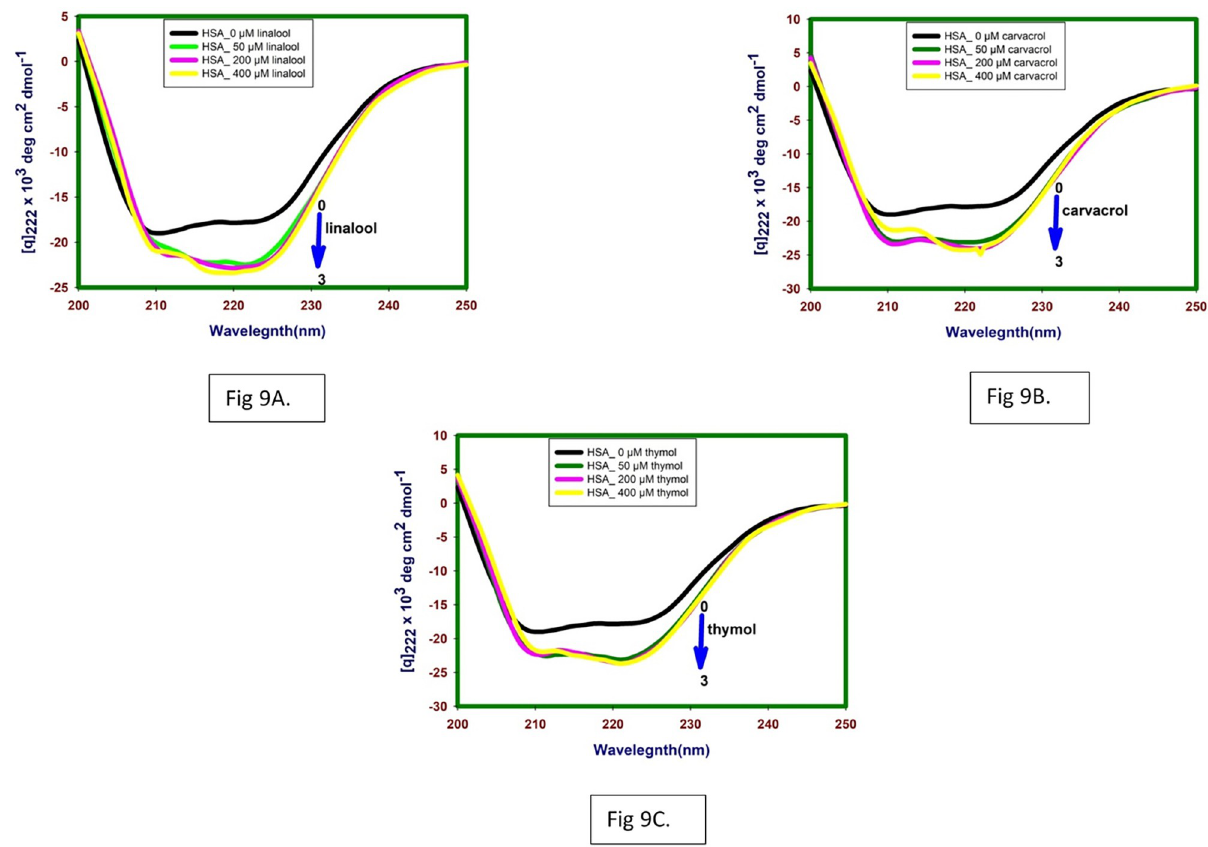
Fig 9. A. Far-UV CD spectra at 24hrs HSA in absence and presence of linalool, (B) carvacrol and (C) thymol at 298.15 K and pH 7.4.